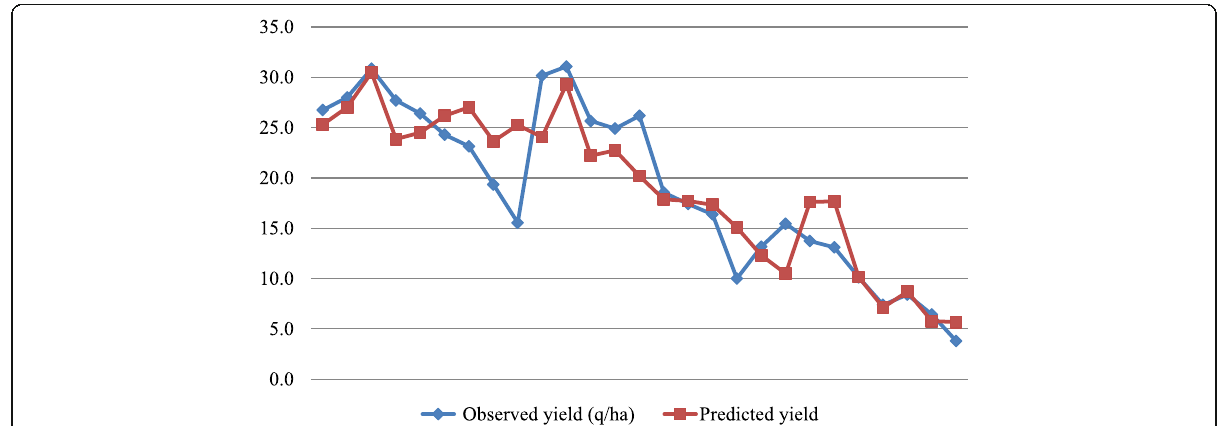
Fig 3 Predicted and observed yield (q/ha) in weather-based equation (yield (q/ha) = 120.4 − 0.035 RTD (0 – 60 days) − 0.039 RTD (61 – 130 days)